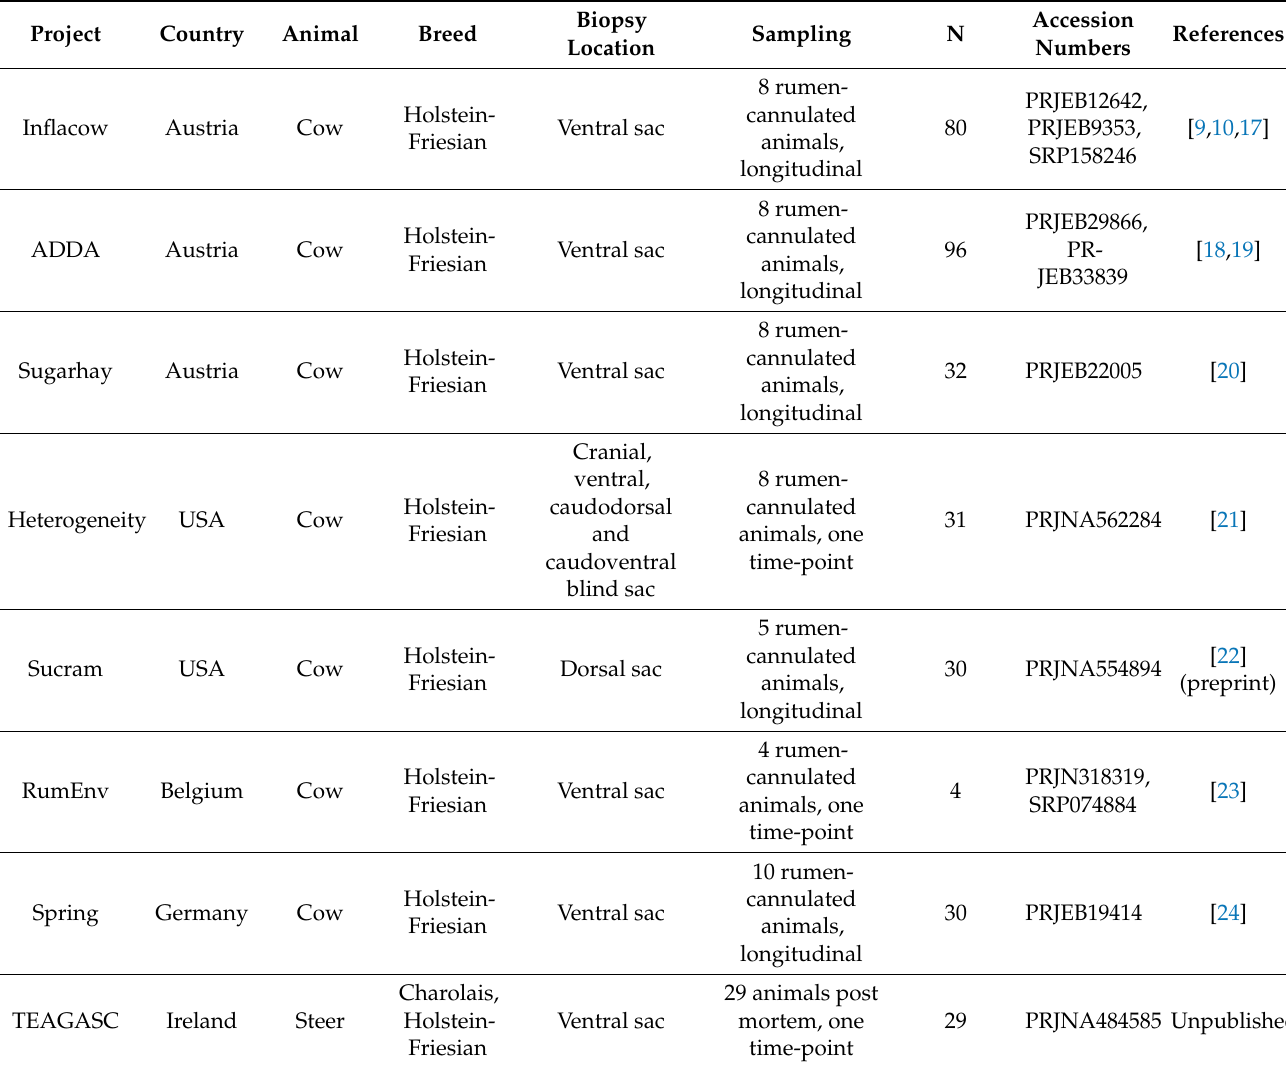
Table 1. Studies included in the meta-analysis. N stands for the total number of sequences retrieved in each study.